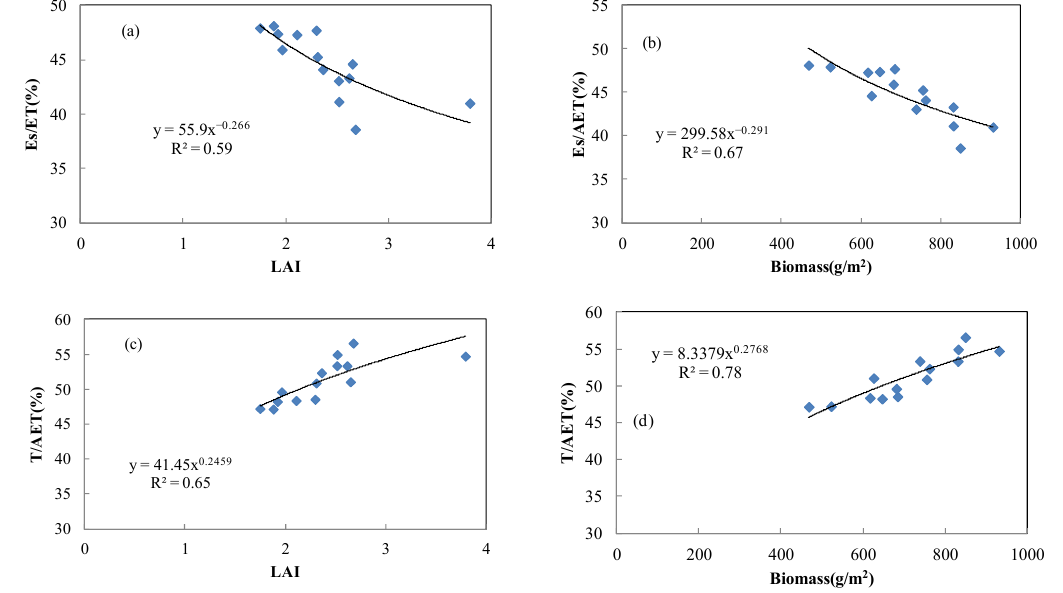
Figure 8. Relationships between LAI, above ground biomass, and evapotranspiration partitioning. ( a ) LAI and Es/AET, ( b ) above ground biomass and Es/AET, ( c ) LAI and T/AET, and ( d ) above ground biomass and T/AET.